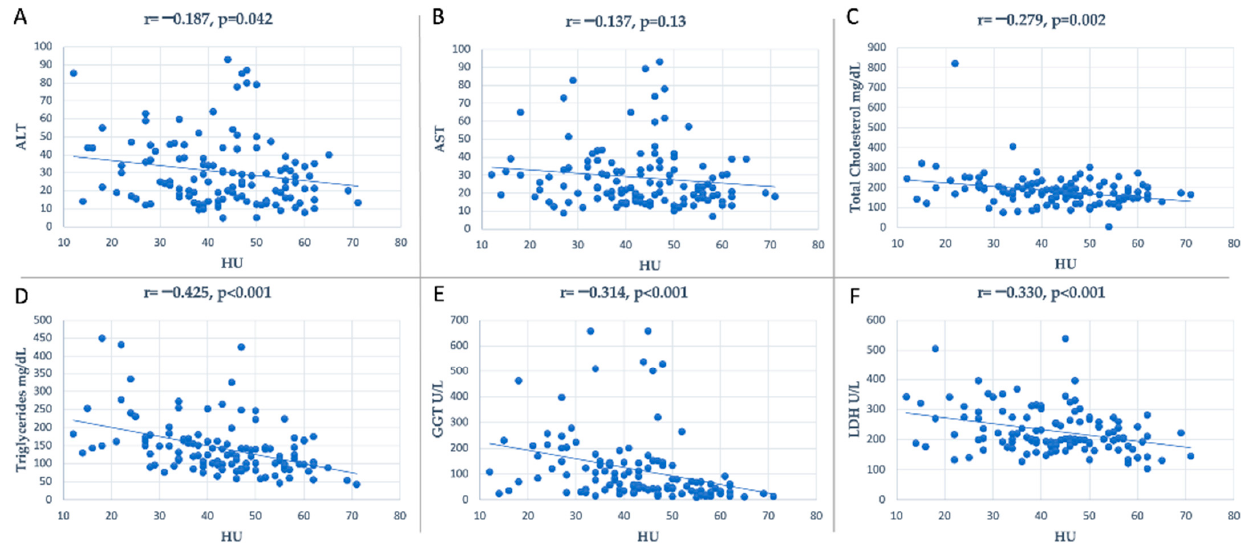
Figure 3. Plot representation of the dispersion of data of the correlation between laboratory parameters and HU density; ( A ): correlation between ALT and HU density; ( B ): correlation between AST and HU density; ( C ): correlation between total cholesterol and HU density; ( D ): correlation between triglycerides and HU density; ( E ): correlation between GGT and HU density; ( F ): correlation between LDH and HU density; ALT, alanine transaminase; AST, aspartate transaminase; GGT, gamma-glutamyl transpeptidase; LDH, lactate dehydrogenase.